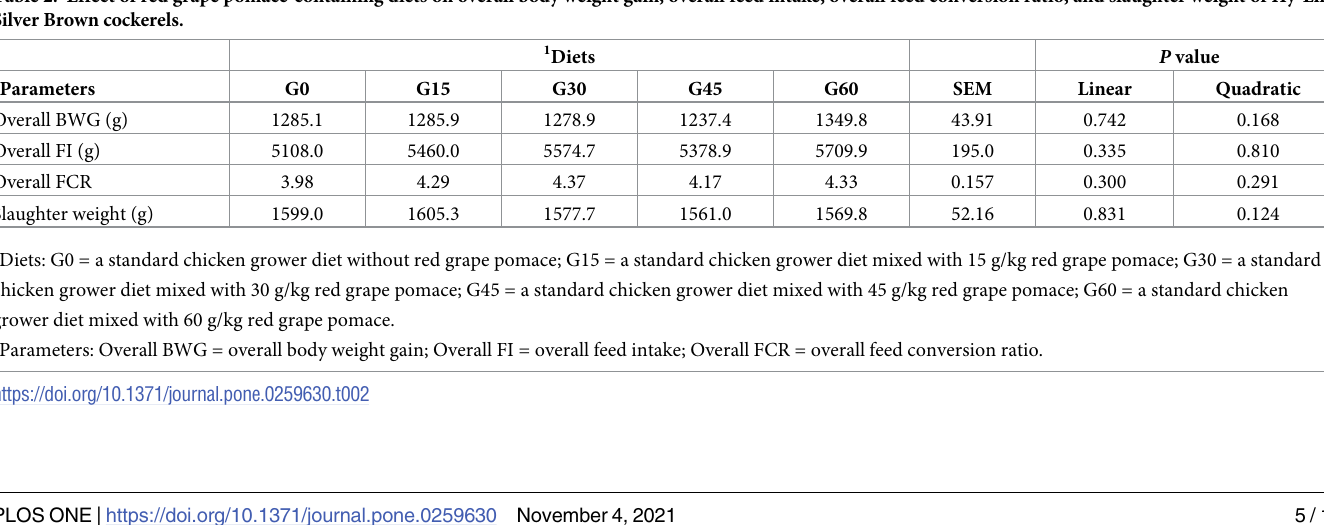
Table 2. Effect of red grape pomace-containing diets on overall body weight gain, overall feed intake, overall feed conversion ratio, and slaughter weight of Hy-Line Silver Brown cockerels.